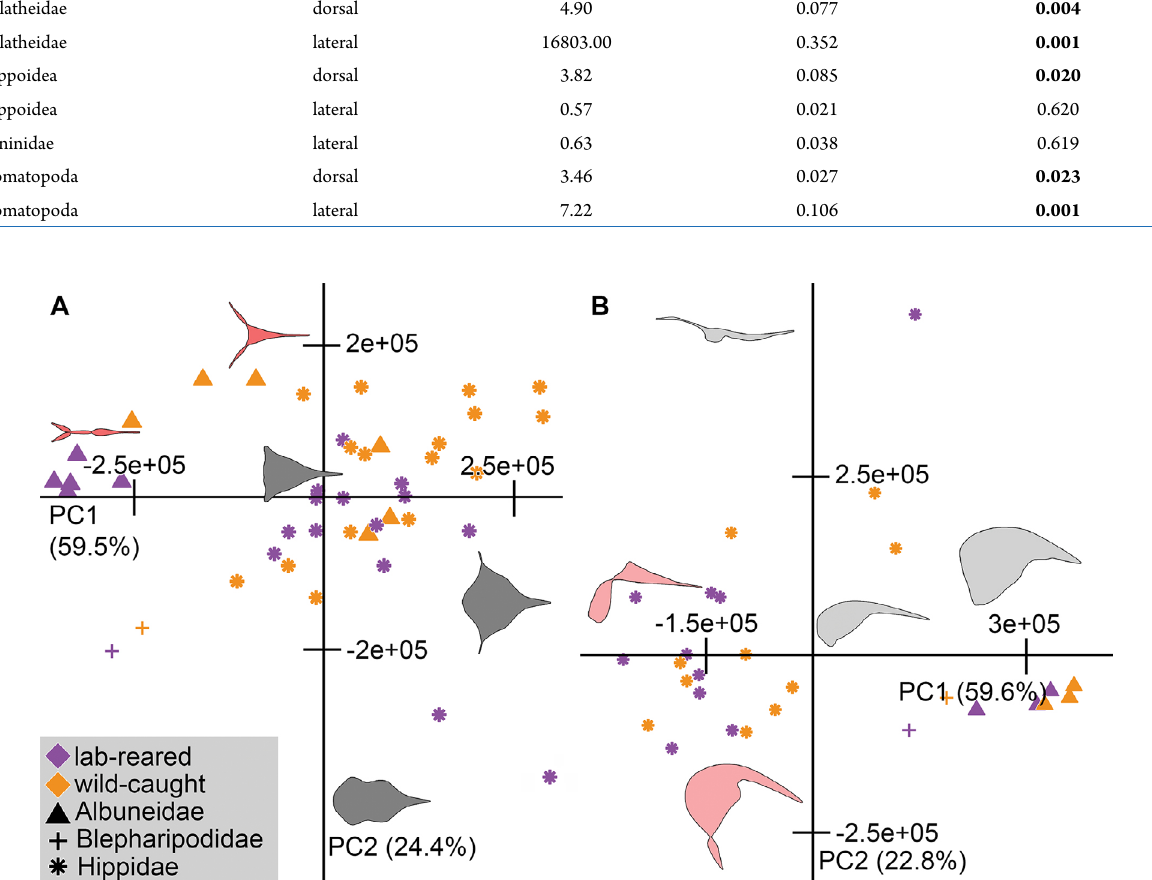
Figure 5. Plot of principal components from the PCA on the SHAPE analysis of shield outlines of Hippoidea. A: PC1 and PC2 of the dorsal analysis plotted against each other. Shapes included are from graphical component loadings and depict the mean shape of the principal component and +/-2 standard deviations of the mean shape. Color coding: dark grey: possible shapes of dorsal analysis; red: impossible shapes of dorsal analysis. B: PC1 and PC2 of the lateral analysis plotted against each other. Shapes included are from graphical component loadings and depict the mean shape of the principal component and +/-2 standard deviations of the mean shape. Color coding: light grey: possible shapes of lateral analysis; light red: impossible shapes of lateral